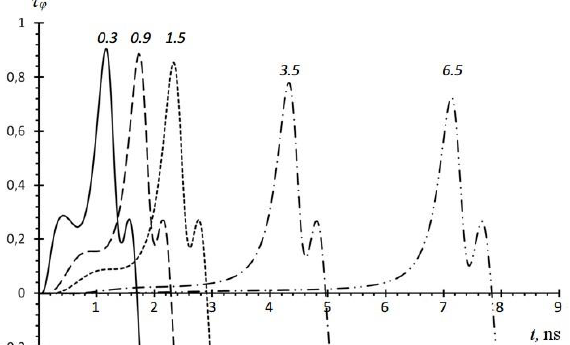
Fig. 3. The time dependences of the torque   .The numbers above the dependences represent the corresponding front duration